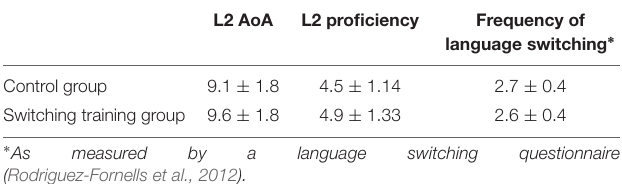
TABLE 1 | Language background information for participants in Experiment